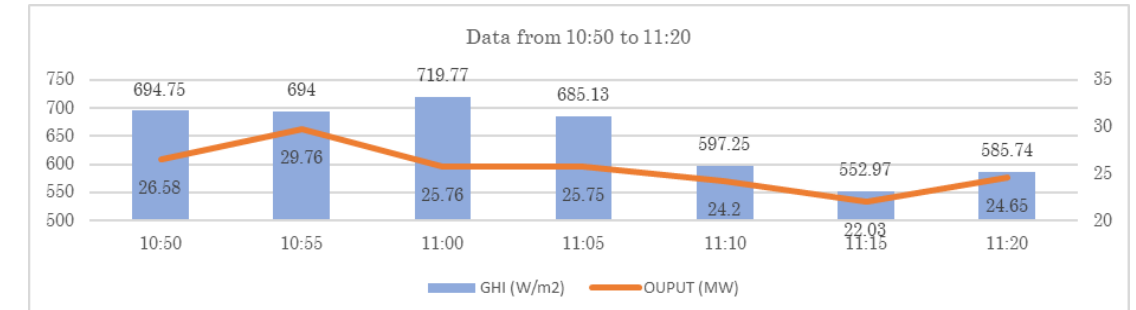
Figure 3. Historical data of Phong Dien Solar farm on June 30, 2019 from 10:50 to 11:20